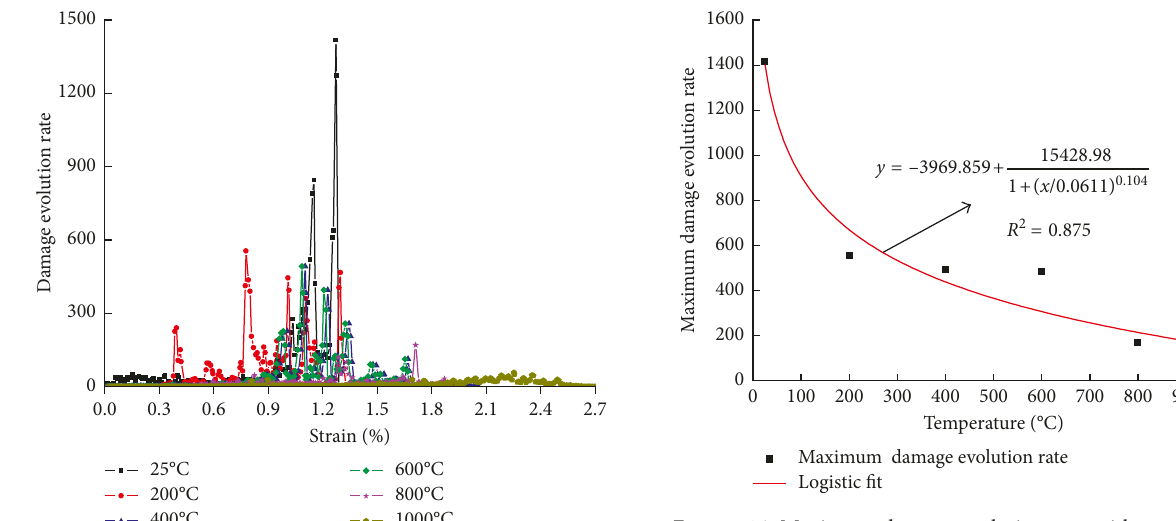
Figure 16: Maximum damage evolution rate with